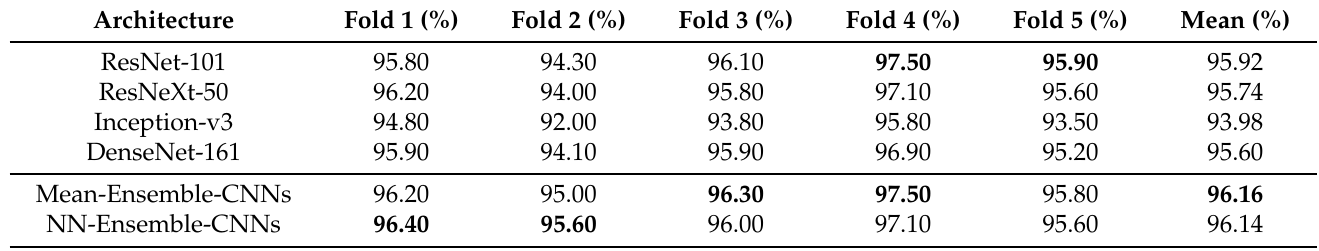
Table 4. Experimental results using ResNet-101, ResNeXt-50, Inception-v3, DenseNet-161, Mean-Ensemble-CNNs and NN-Ensemble- CNN on Kather-CRC-2016 database using the accuracy measurement.